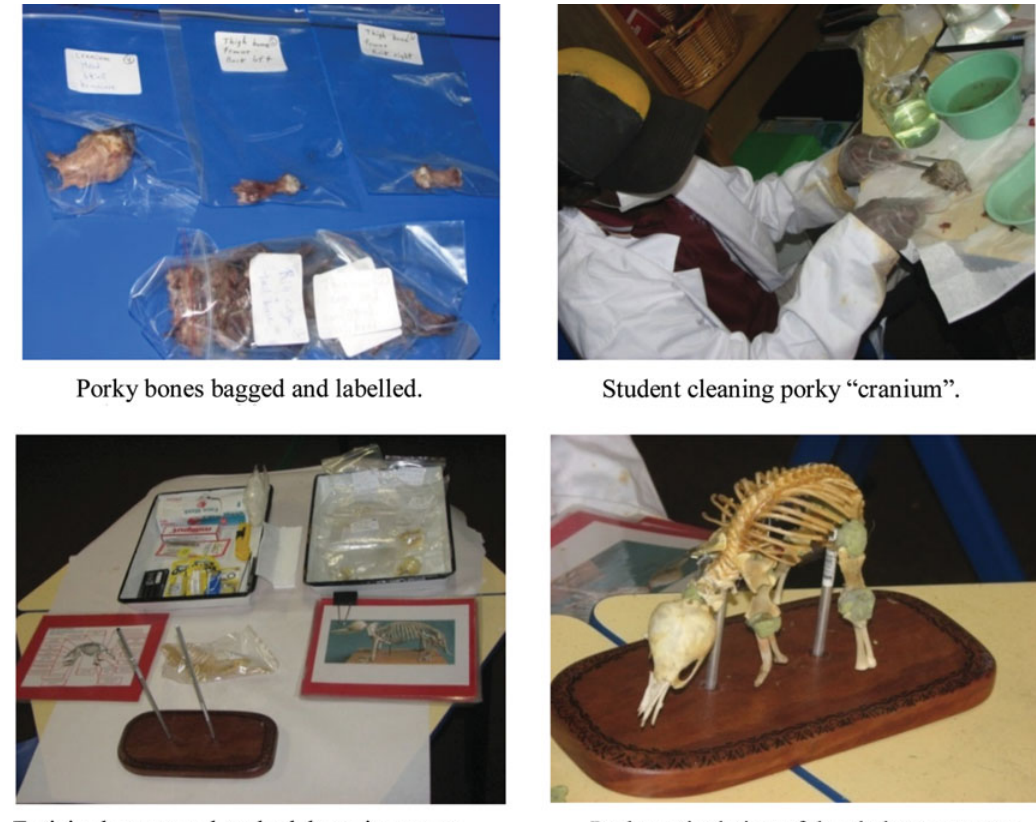
(Colour online) Porky articulation: beautiful